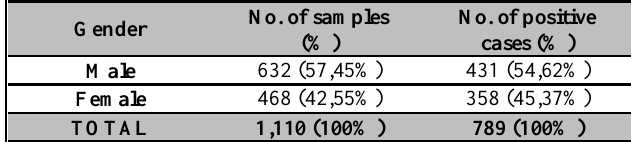
Table 1. Gender wise distribution of patients with URTIs